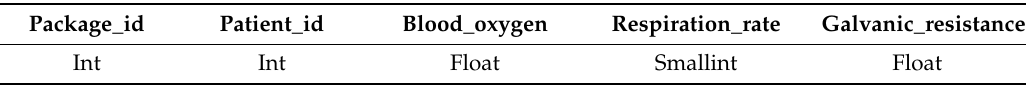
Table 2. Fixed measurement station package.